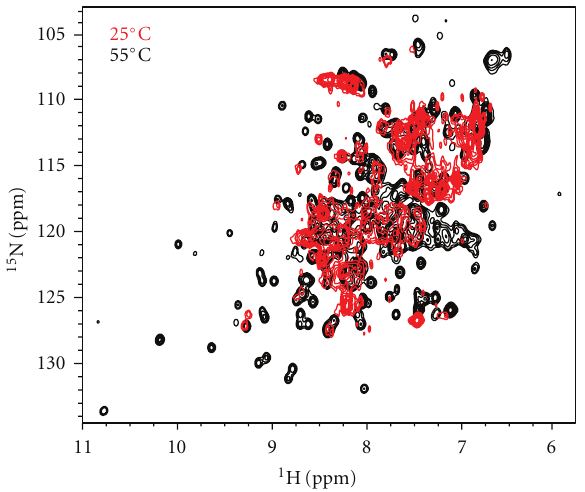
Figure 5: Elevated temperatures yield interpretable NMR spectra for the 78 kDa heterotetrameric Pfu Pop5-RPP30 complex. Overlay of two-dimensional 1 H- 15 N correlation spectra of [U- 15 N]-RPP30 in complex with unlabeled Pop5 at 55 ◦ C (black) and 25 ◦ C (red) reveal excessive broadening at 25 ◦ C that is partly overcome at 55 ◦